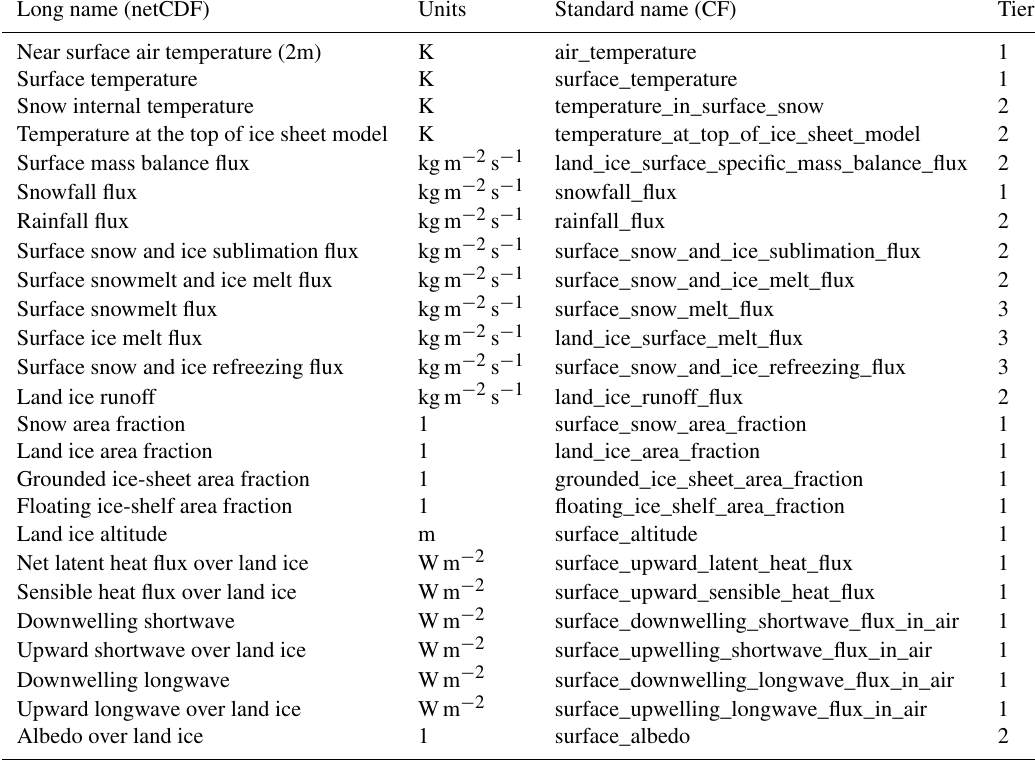
Table A1. Data in the LImon table (Monthly Mean Land Cryosphere Fields) and/or Amon table (Monthly Mean Atmospheric Fields) needed to capture the glaciated/ice-sheet surface realm. These fields are saved on the atmosphere grid and contain monthly output. Tier indicates the priority of the variable: Mandatory (1), Desirable (2), Experimental (3). These variables are requested for climate models participating in the diagnostic component of ISMIP6 (Table 1), and for the XXX-withism experiments (Table 2). Flux variables are defined as positive when the process adds mass or energy to the ice sheet and negative otherwise.